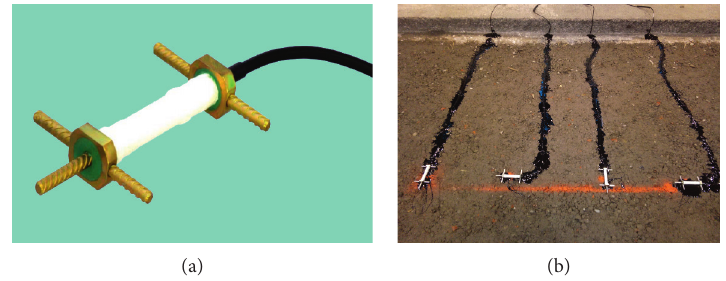
Figure 3: The diagrams of (a) strain gauge and (b) field installation of strain gauges.